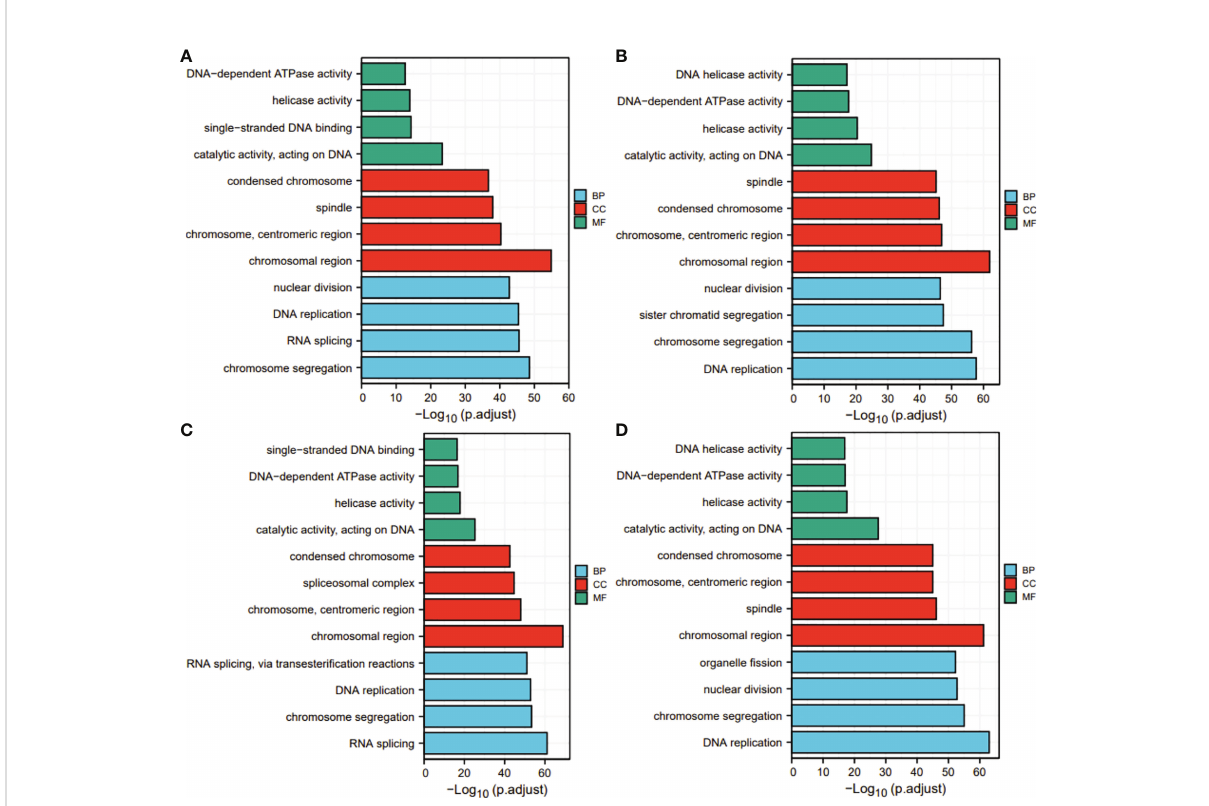
FIGURE 7 GO analysis of SKA1 (A) , SKA2 (B) , SKA3 (C) co-expression genes, and intersection co-expression genes among with SKA1/2/3 (D) . GO, Gene ontology.